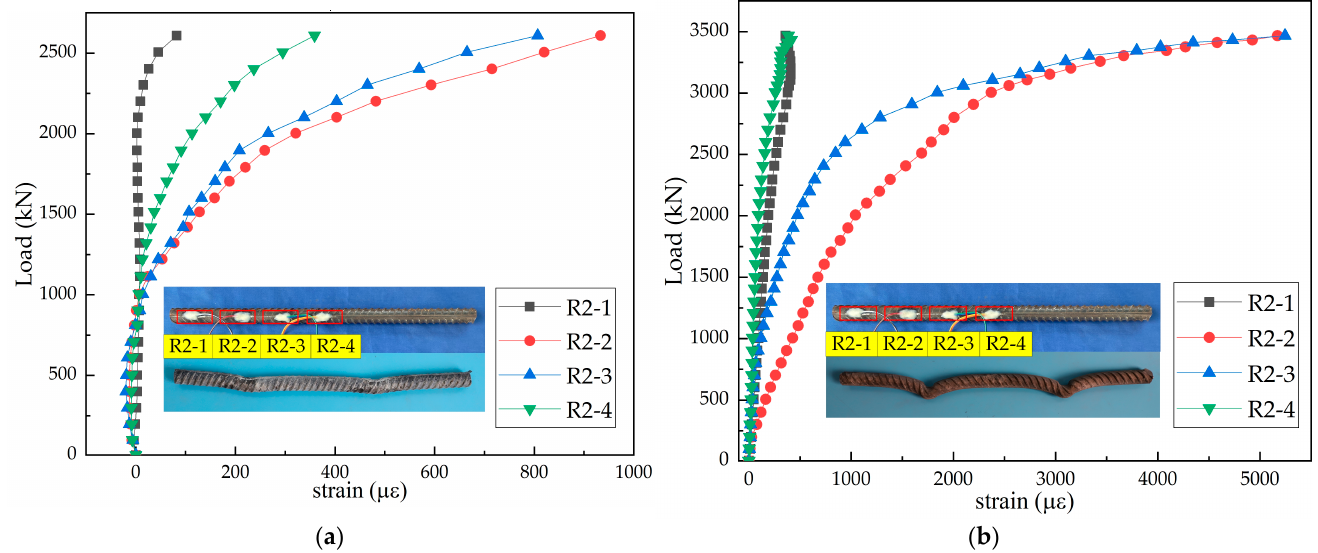
Figure 9. Load–strain curves of penetrating rebar: ( a ) N-20-3 and ( b ) S-16-3.